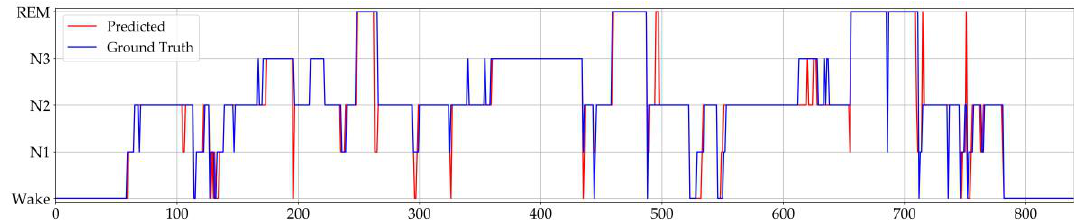
Figure 5. Manually labeled and predicted hypnogram of subject 6 on the first night in the sleep-edfx database.